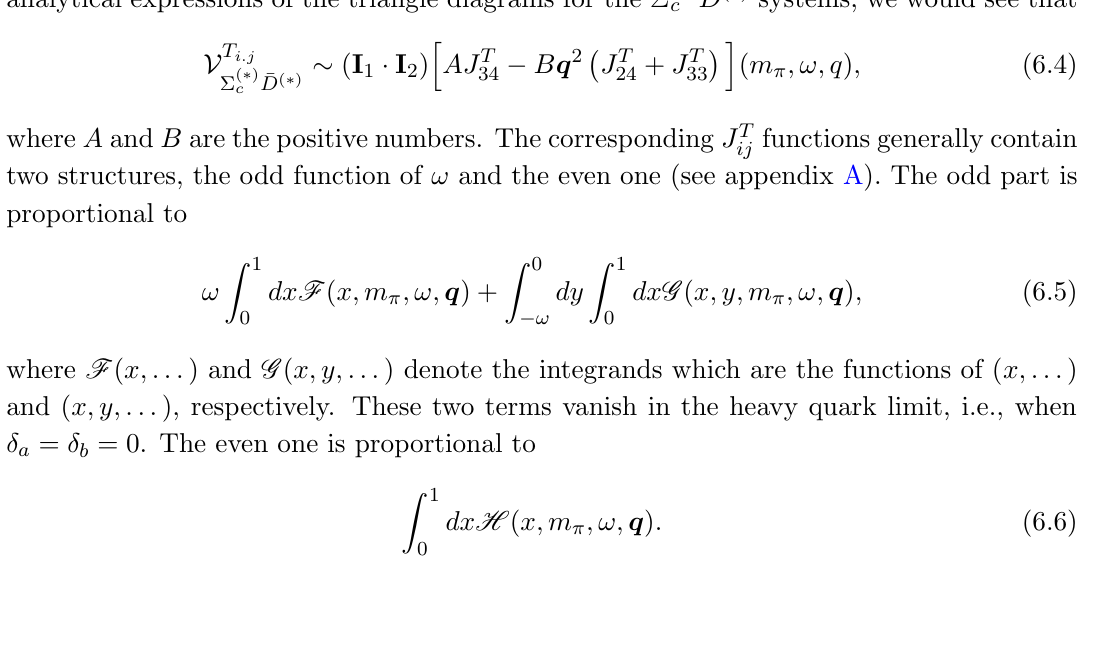
(cid:22) D ] [( a ), ( b )] and [(cid:6) (cid:3) [( c ), ( d )] systems in the cases of (cid:14) a = (cid:14) b = 0 3 c 2 2